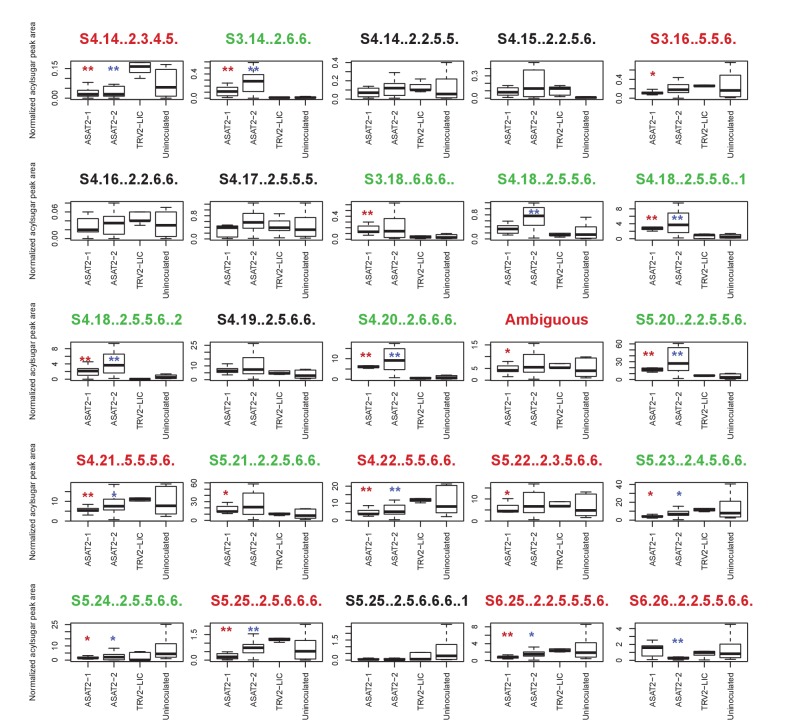
Individual acylsugar levels in SsASAT2 VIGS replicate 1.The boxplots denote the summed normalized acylsugar peak areas, obtained using the LC/MS extracted ion chromatograms, across all plants in the experiment. Blue and red asterisks indicate significant changes in SsASAT2-1_TRV2-LIC and SsASAT2-2_TRV2-LIC comparisons, respectively. *p<0.05; **p<0.01 using the KS test. Acylsugar names in green show significant increases and the names in red show significant decreases compared with the TRV2-LIC control. These results show that C2 acylated derivatives of S3:16(5,5,6), S3:17(5,6,6) and S3:18(6,6,6) [e.g.: S4:18(2,5,5,6); S5:20(2,2,5,5,6)] increased significantly, while C5 derivatives of these acylsugars [eg: S4:21(5,5,5,6); S5:25(2,5,6,6,6)] decreased significantly in the silenced lines. One possible explanation for this result is that another transcript was silenced in addition to SsASAT2. However, the single Salpiglossis transcript with 100% identity to the silencing fragment over 18 nucleotides is not preferentially expressed in the trichomes of uninfected Salpiglossis (~360 reads in trichome;~550 reads in shaved stem) and is annotated as an ion channel. Thus, the reason for this unusual phenotype is still unclear.